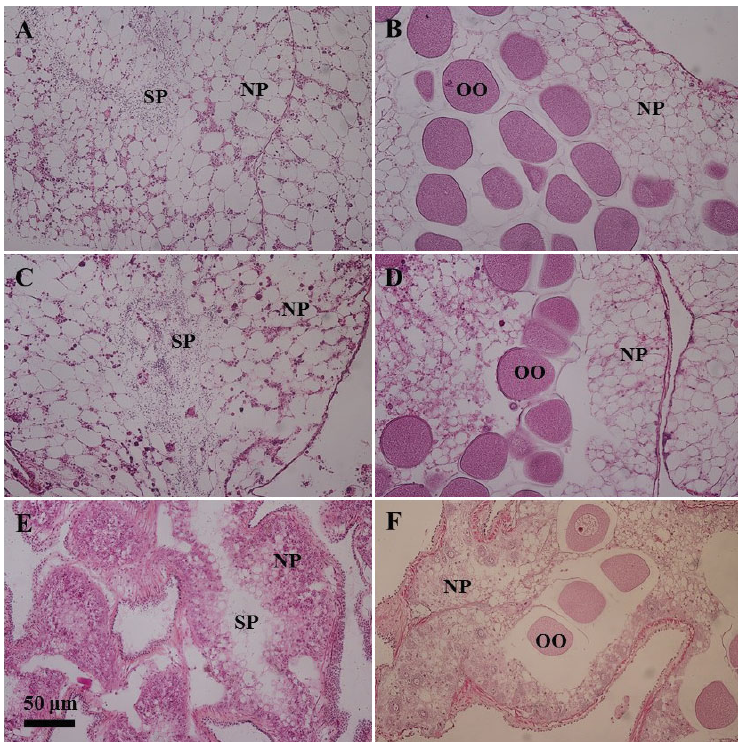
Fig. 4. Histological examination of the gonads of Gracilechinus acutus using haemotoxylin erythrosin saffron stain as (A) male urchins fed the aquafeed treatment, (B) female urchins fed the aquafeed treatment, (C) male urchins fed the composite treatment, (D) female urchins fed the composite treatment, (E) male urchins fed the natural treatment and (F) female urchins fed the natural treatment. NP: nutritive phagocyte; OO: oocyte; SP: spermatozoa.